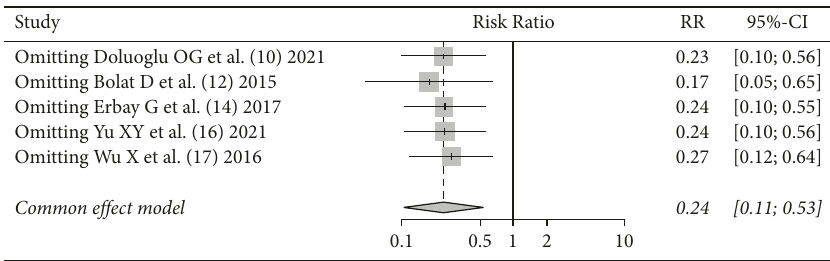
Figure 6: Sensitivity analysis of incidence indicators of bladder perforation.